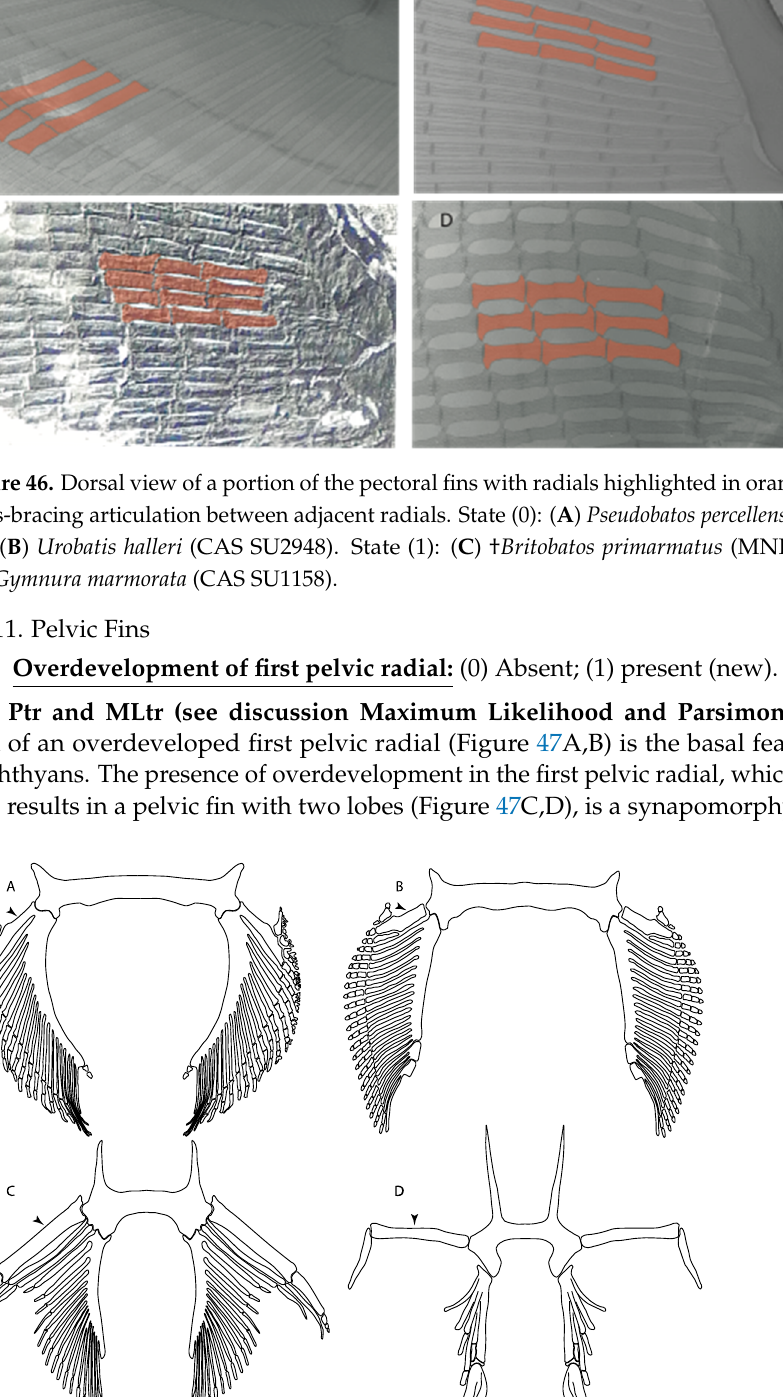
Figure 47. Dorsal view of pelvic girdle. State (0): ( A ) Platyrhina sinensis (AMNH 44055) redrawn and